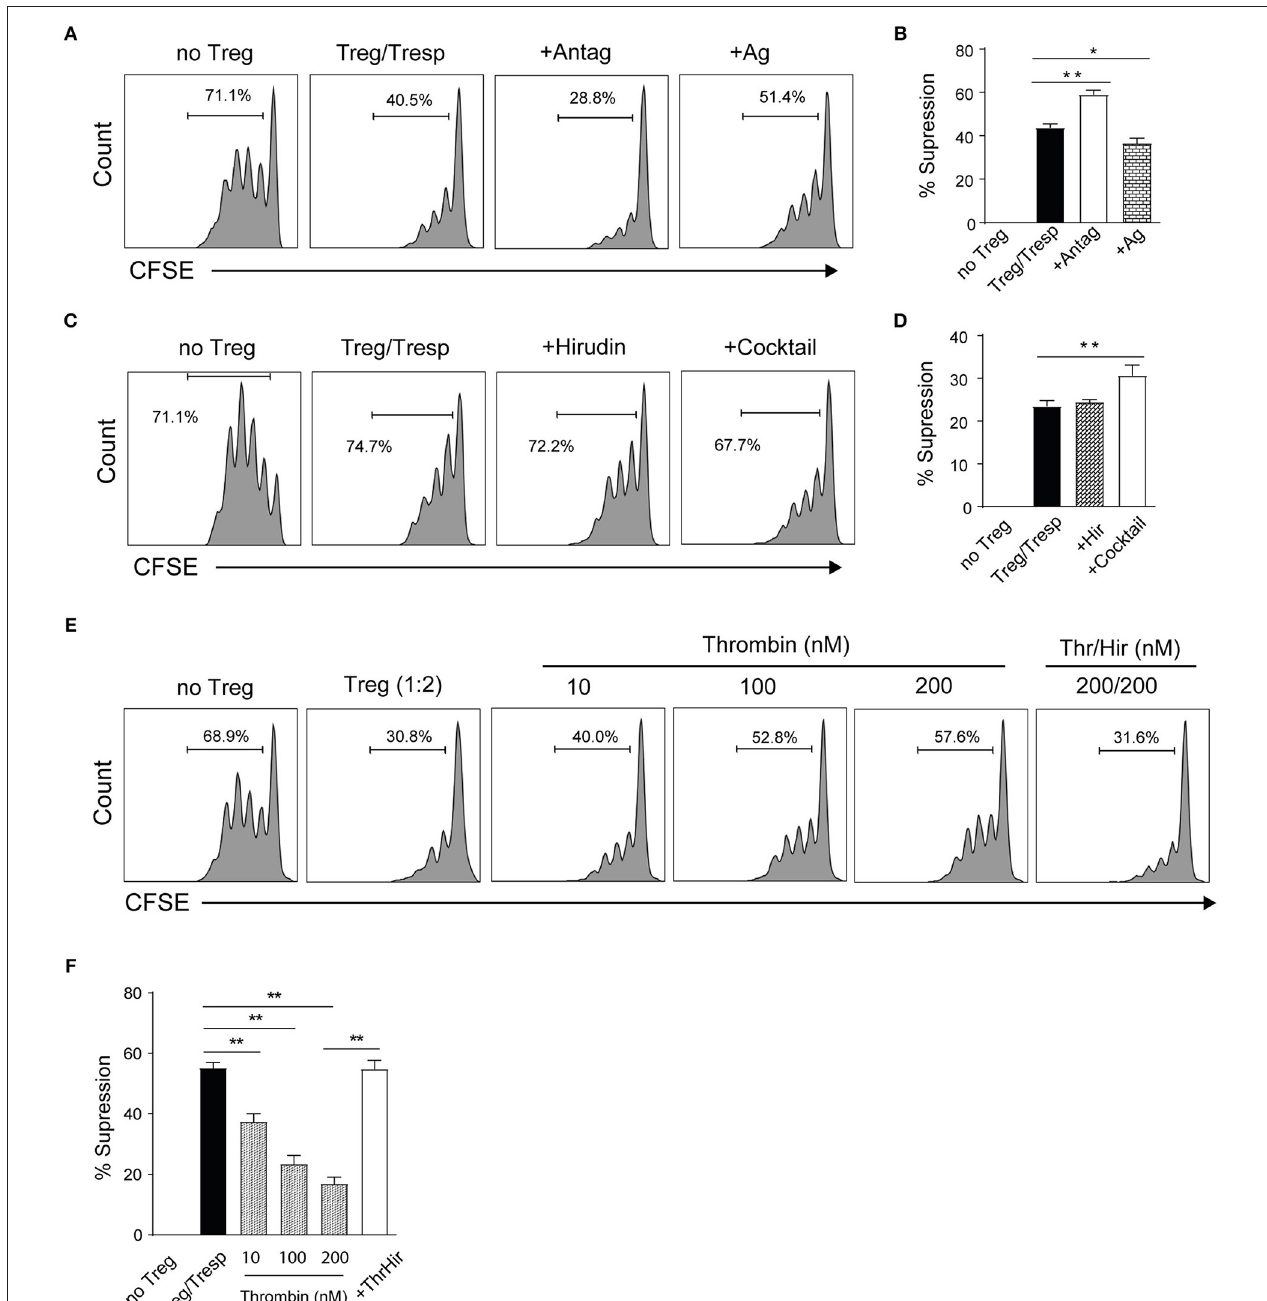
FIGURE 4 | PAR4 signaling modulates the suppressive capacity of Tregs. CD4 + CD25 + Tregs from WT spleen and pLN were freshly isolated. Representative histograms (A) and pooled data (B) showing in vitro suppression of CFSE-labeled PAR4ko Tresps by WT Tregs (filled bar; in the ratio of 2 to 1) in the absence or presence of a PAR4 antagonist (Antag; open bar) or agonist (Ag; dotted bar) in 72h suppressive assays co-cultured with PAR4ko APCs and addition of anti-CD3. Graphs show mean ± SEM from four experiments. Data were analyzed by unpaired two-way t -test. * p < 0.05 and ** p < 0.01 in comparison between the Treg groups without or with PAR4 antagonist or agonist, respectively. Representative histograms (C) and pooled data (D) showing in vitro suppression of CFSE-labeled PAR4ko Tresps by WT Tregs (filled bar; in the ratio of 2 to 1) in the absence or presence of thrombin inhibitor hirudin (Hir; dotted bar) or protease inhibitor cocktail (open bar) in 72h suppressive assays. Graphs show mean ± SEM from four experiments. Data were analyzed by unpaired two-way t -test. ** p < 0.01 in comparison between the Treg groups without or with the cocktail, respectively. Representative histograms (E) and pooled data (F) showing in vitro suppression of CFSE-labeled PAR4ko Tresps by WT Tregs (in the ratio of 2 to 1) in the absence (filled bar) or presence of thrombin (Thr) in different concentrations without (dotted bars) or with Hir (open bars). Graphs show mean ± SEM from four experiments. Data were analyzed by unpaired two-way t -test. ** p < 0.01 in comparison between the WT Tregs without or with